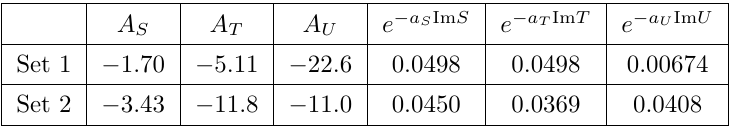
Table 3 . The resulting values for the parameters in front of the